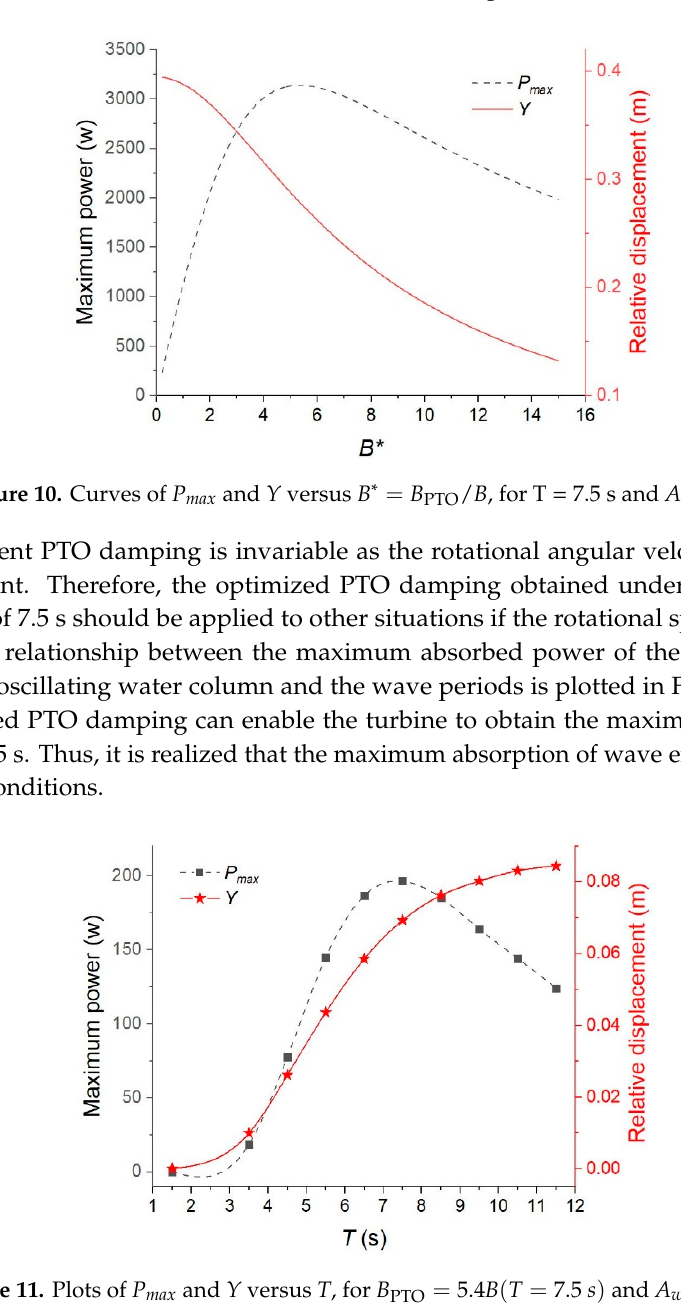
Figure 11. Plots of P max and Y versus T , for B PTO = 5.4 B ( T = 7.5 s ) and A w = 0.25 Figure 11. Plots of 𝑃 (cid:3040)(cid:3028)(cid:3051) and Y versus 𝑇 , for 𝐵 (cid:2900)(cid:2904)(cid:2899) = 5.4𝐵(𝑇 = 7.5 𝑠) and 𝐴 (cid:3050) = 0.25 m. Figure 11. Plots of 𝑃 (cid:3040)(cid:3028)(cid:3051) and Y versus 𝑇 , for 𝐵 (cid:2900)(cid:2904)(cid:2899) = 5.4𝐵(𝑇 = 7.5 𝑠) and 𝐴 (cid:3050) = 0.25 m.